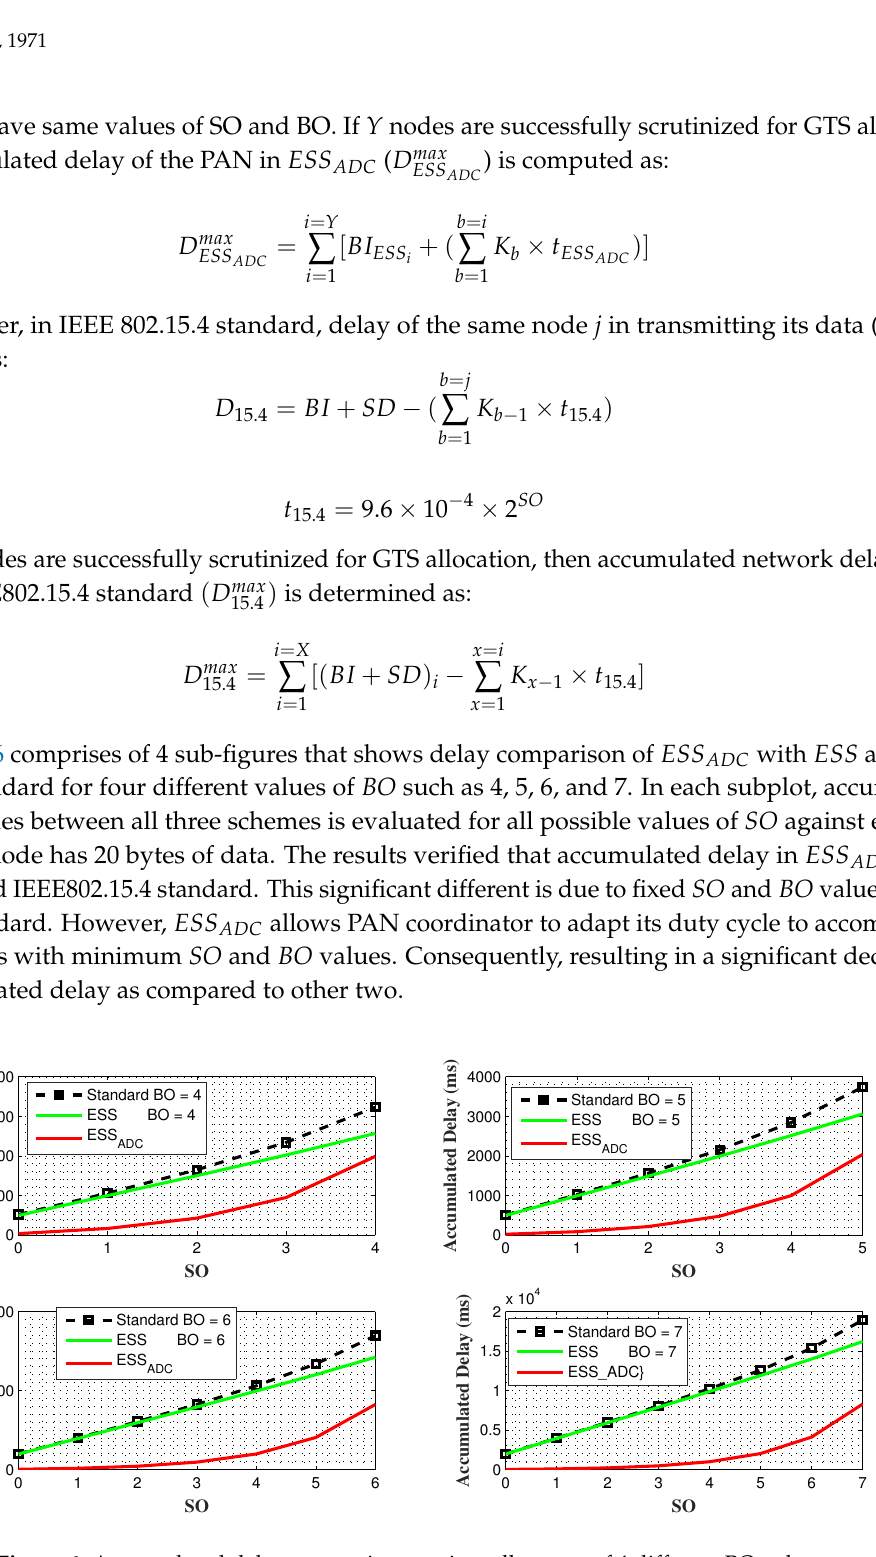
Figure 6. Accumulated delay comparison against all ranges of 4 different BO